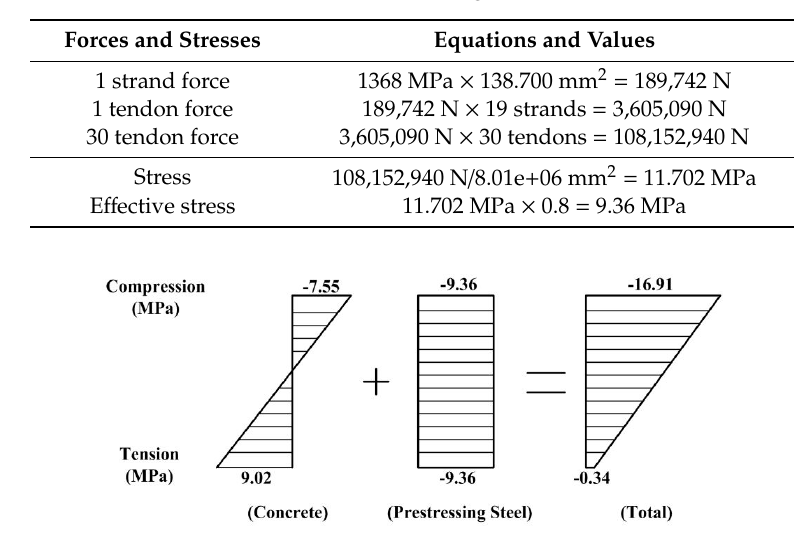
Figure 13. Prestressed tendon arrangement. Table 7. Prestressing force.